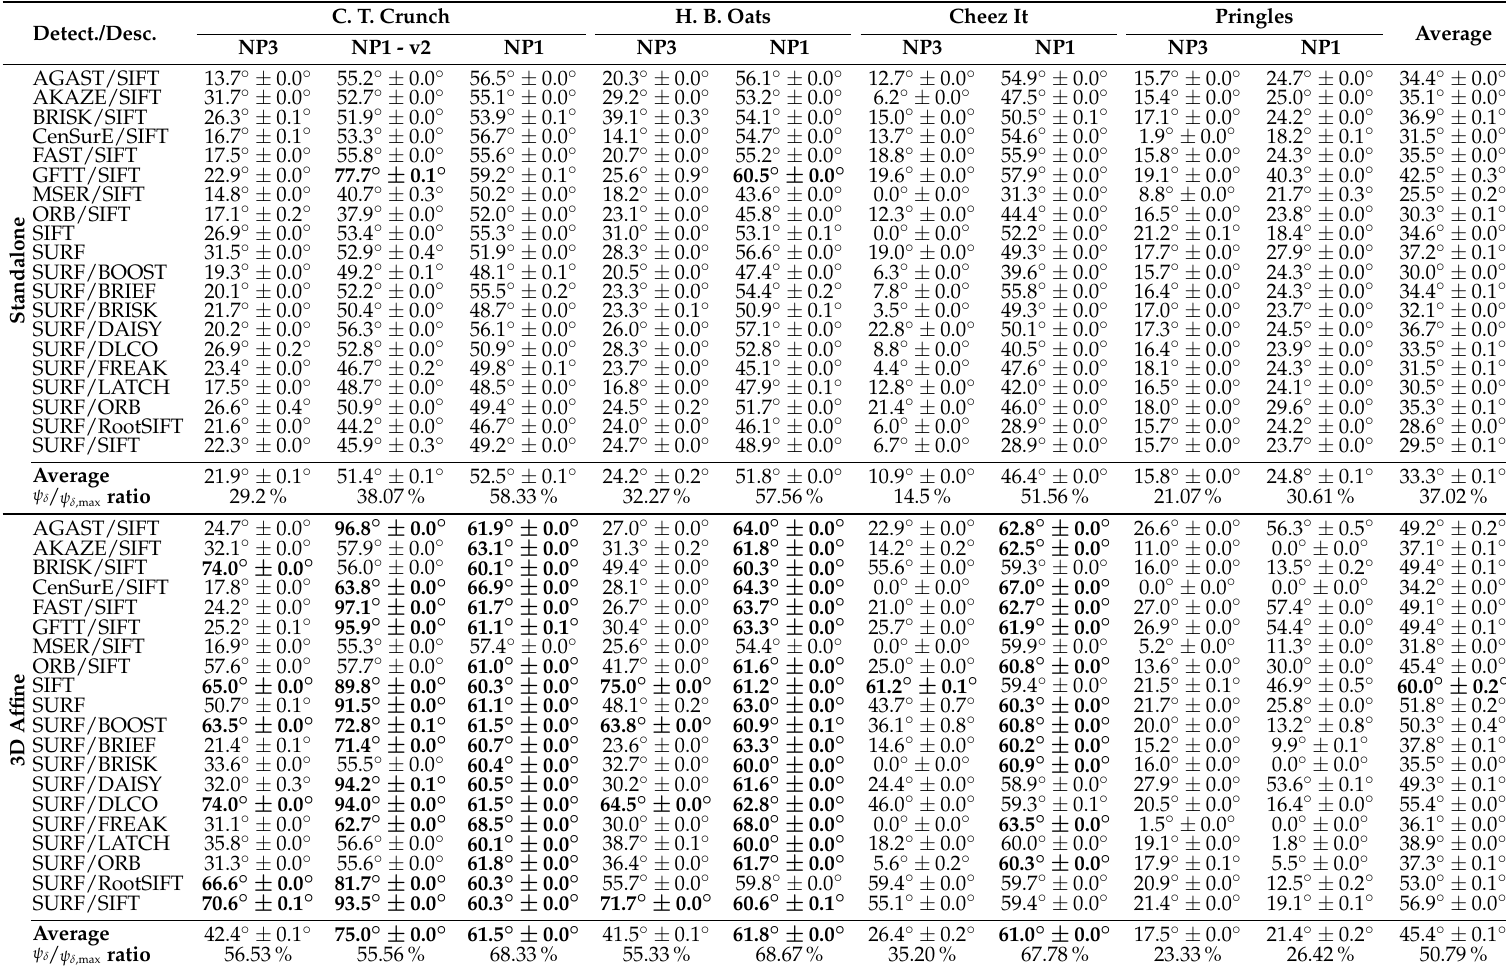
Table 3. Overall viewpoint invariance, ψ δ , for various features and datasets. The scores exceeding the targeted threshold, ψ ∆ , are shown in bold. Detectors and descriptors are detailed in Table